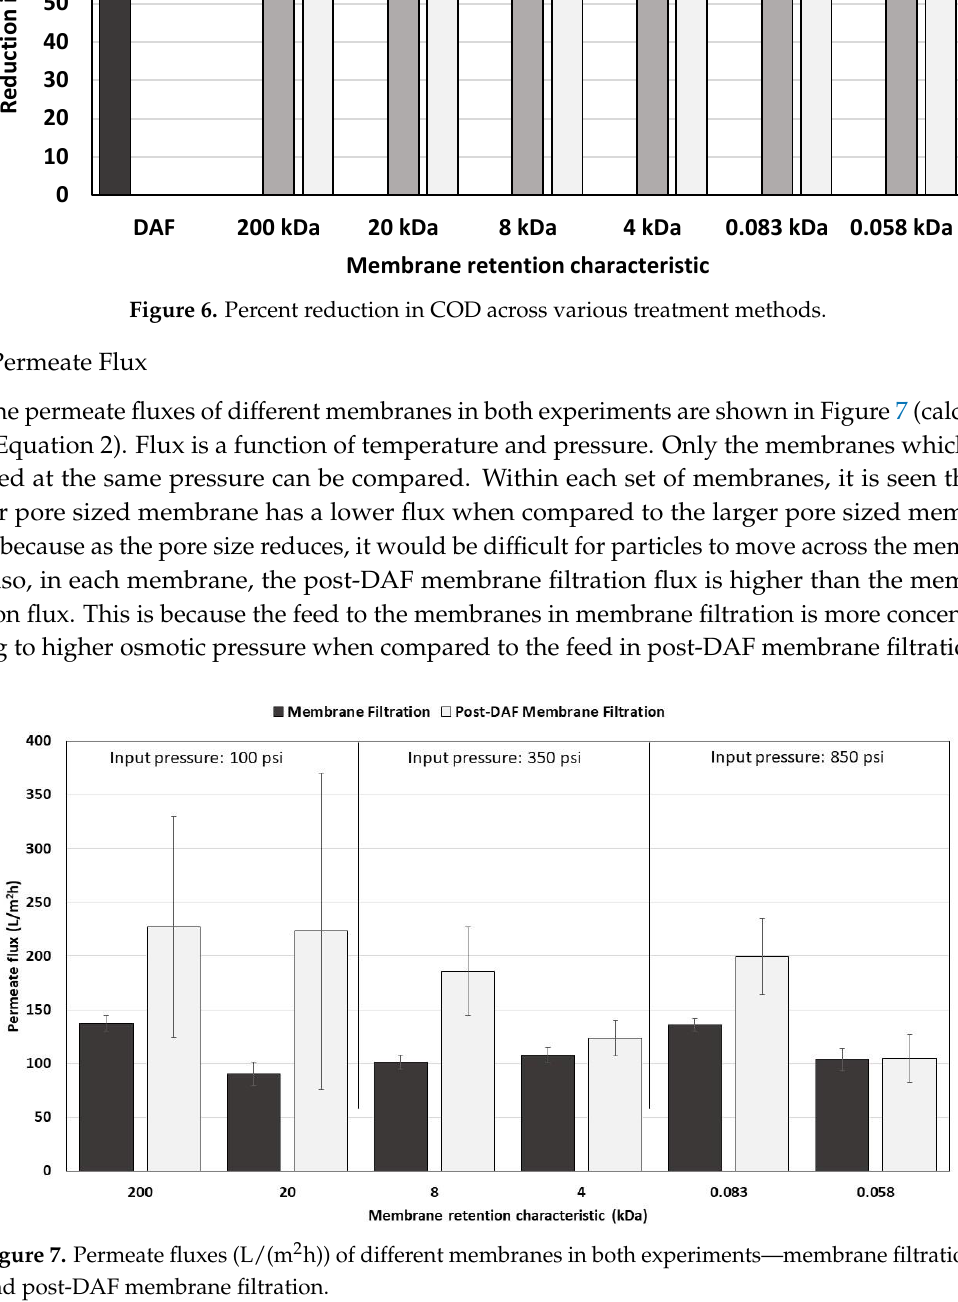
Figure 7. Permeate fluxes (L/(m 2 h)) of different membranes in both experiments—membrane filtration and post-DAF membrane filtration.